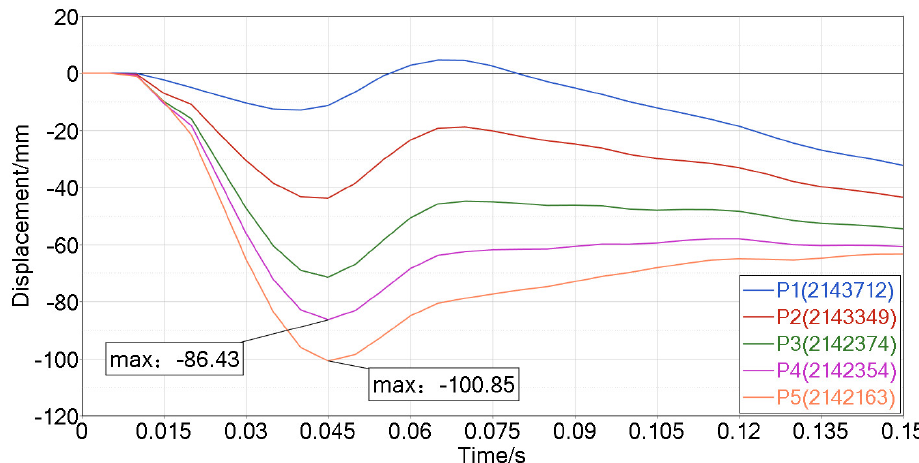
Figure 7. Amount of intrusion at each point of the B-pillar inner